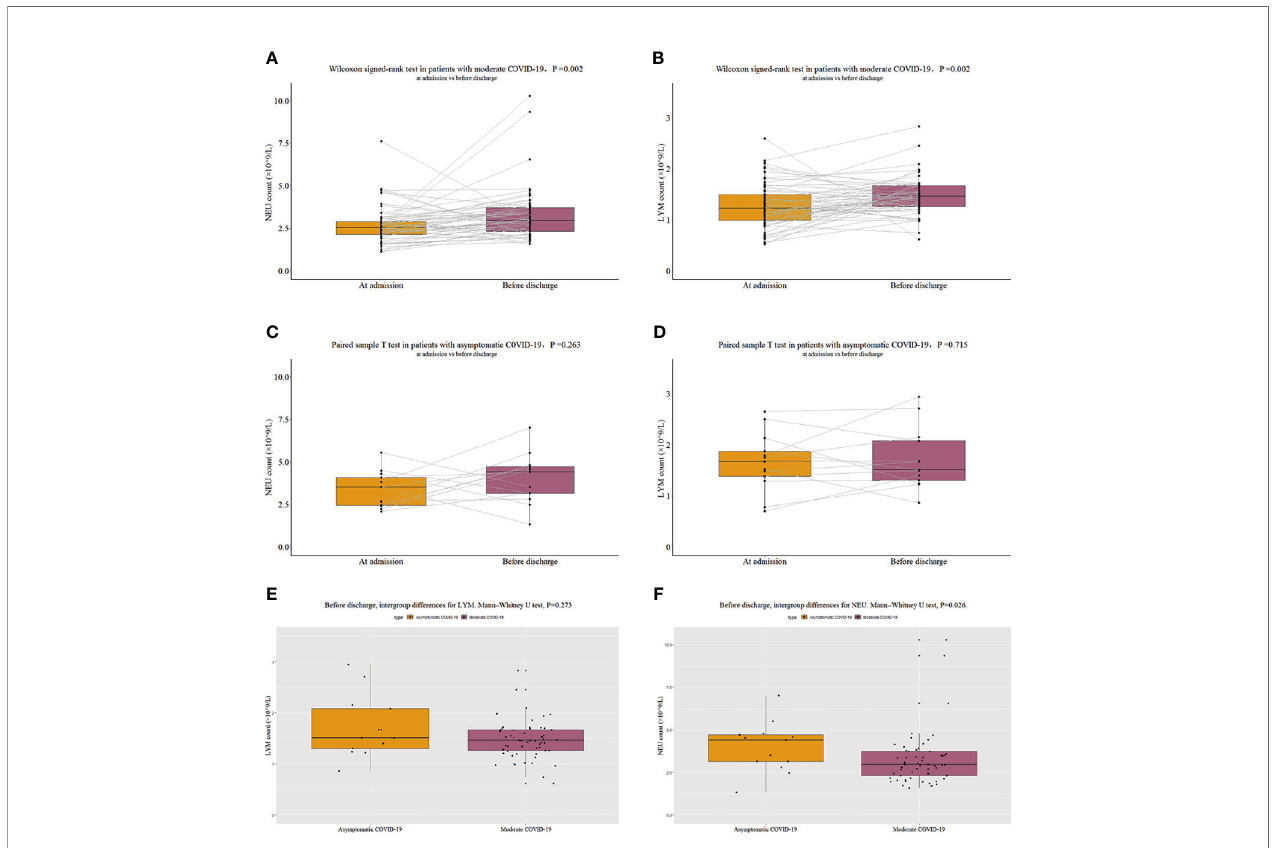
FIGURE 4 | NEU count and LYM count. (A) NEU counts at admission and before discharge in patients with moderate COVID-19. (B) LYM counts at admission and before discharge in patients with moderate COVID-19. (C) NEU counts at admission and before discharge in patients with asymptomatic COVID-19. (D) LYM counts at admission and before discharge in patients with asymptomatic COVID-19. (E) Comparison of LYM counts before discharge in patients with moderate COVID-19 and patients with asymptomatic COVID-19. (F) Comparison of NEU counts before discharge in patients with moderate COVID-19 and patients with asymptomatic